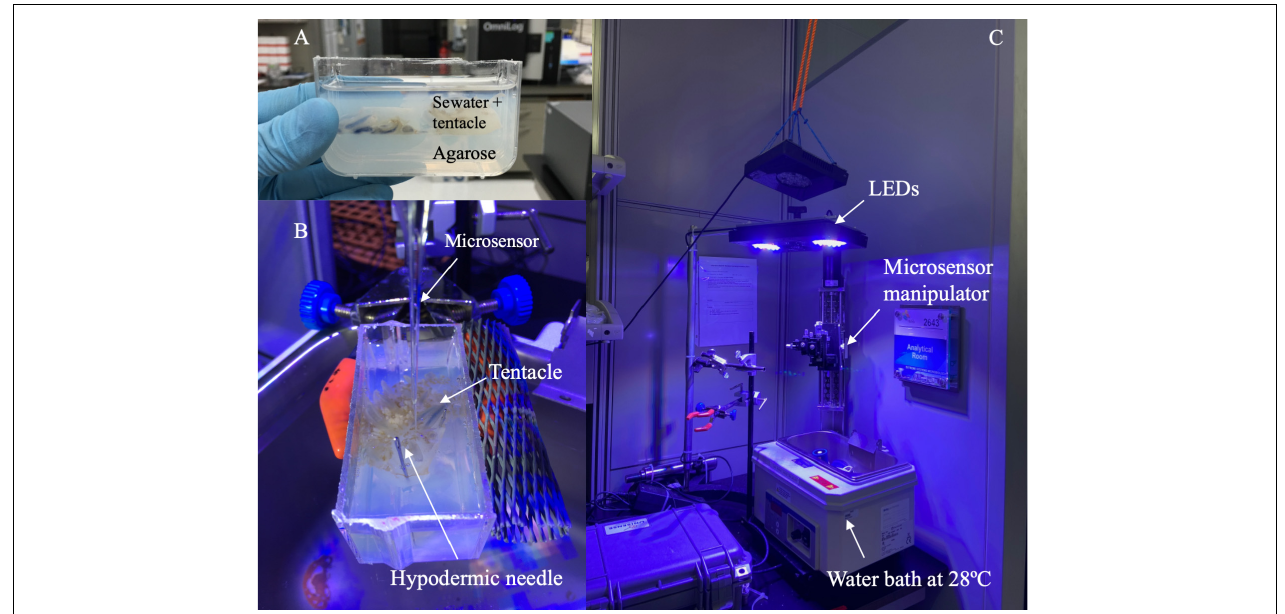
FIGURE 1 | Experimental set up. (A) Oral arms were placed into a transparent container on a 2% agarose layer and covered with seawater from the aquarium. (B) Oral arms were kept in place using hypodermic needles. (C) The container with the oral arm was placed into a water bath set at 28 o C (to mimic environmental conditions). The set-up included a custom-made arm equipped with LEDs and used to adjust the distance between the oral arm and lights. The microsensor manipulator was used to control the microsensor during our measurements.